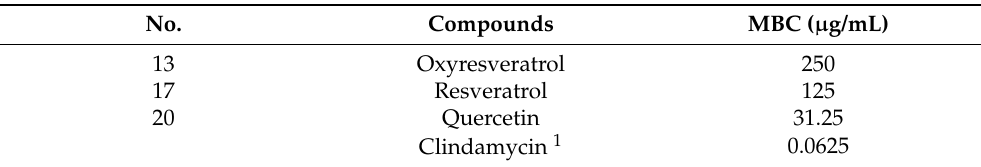
Table 3. Minimum bactericidal concentration (MBC) of active compounds 13, 17, and 20